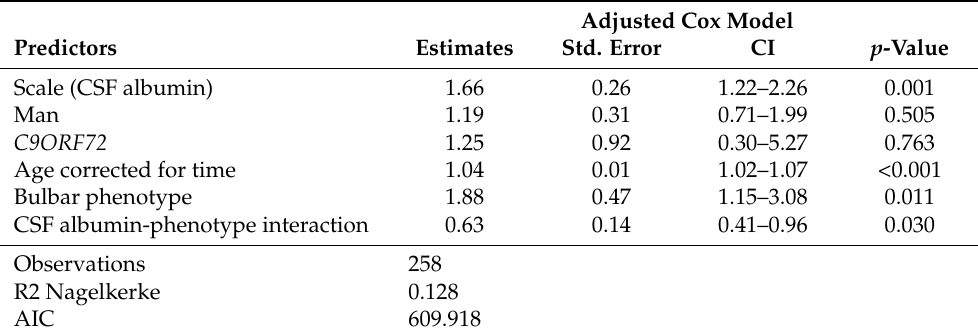
Table 7. Adjusted Cox model according to the CSF albumin values. In this model adjusted for the interaction with the phenotype, the HR of the interaction is 0.63. Therefore, for patients with the bulbar phenotype, the HR of CSF albumin is 1.04 (95% CI 0.50 to 2.17) while for those with the spinal phenotype, it is 1.66. This means that if the CSF albumin value is increased by one SD compared to the mean (117.26 compared to 273.77), and if the patient has a spinal phenotype, this increase will mean an increase in the risk of death of 66.12%. In contrast, if the patient has a bulbar phenotype, we do not observe a statistically significant effect. Age corrected for time refers to the time elapsed between onset and